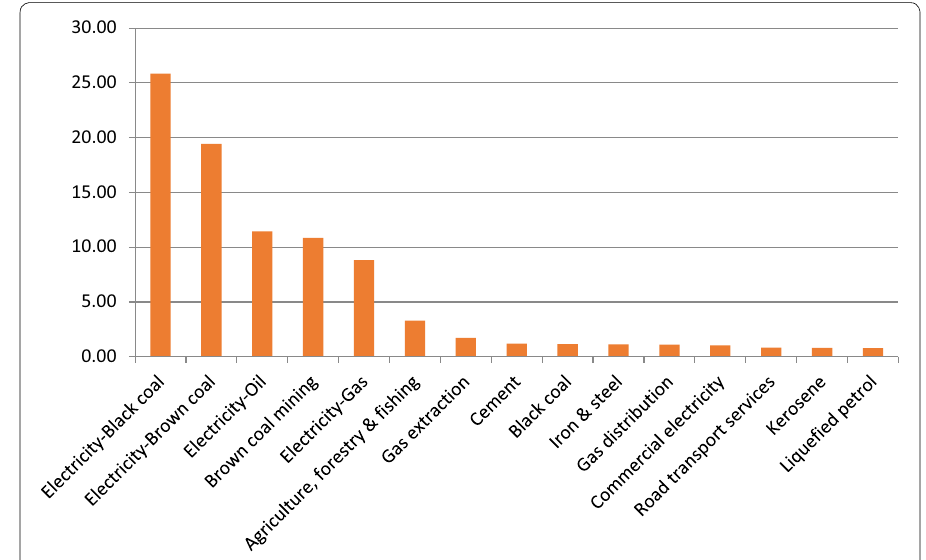
Fig. 1 Carbon emissions intensity by sector in Australia (kilotonnes/A$million). Source Calculated from data obtained from the Department of Climate Change and Energy Efficiency